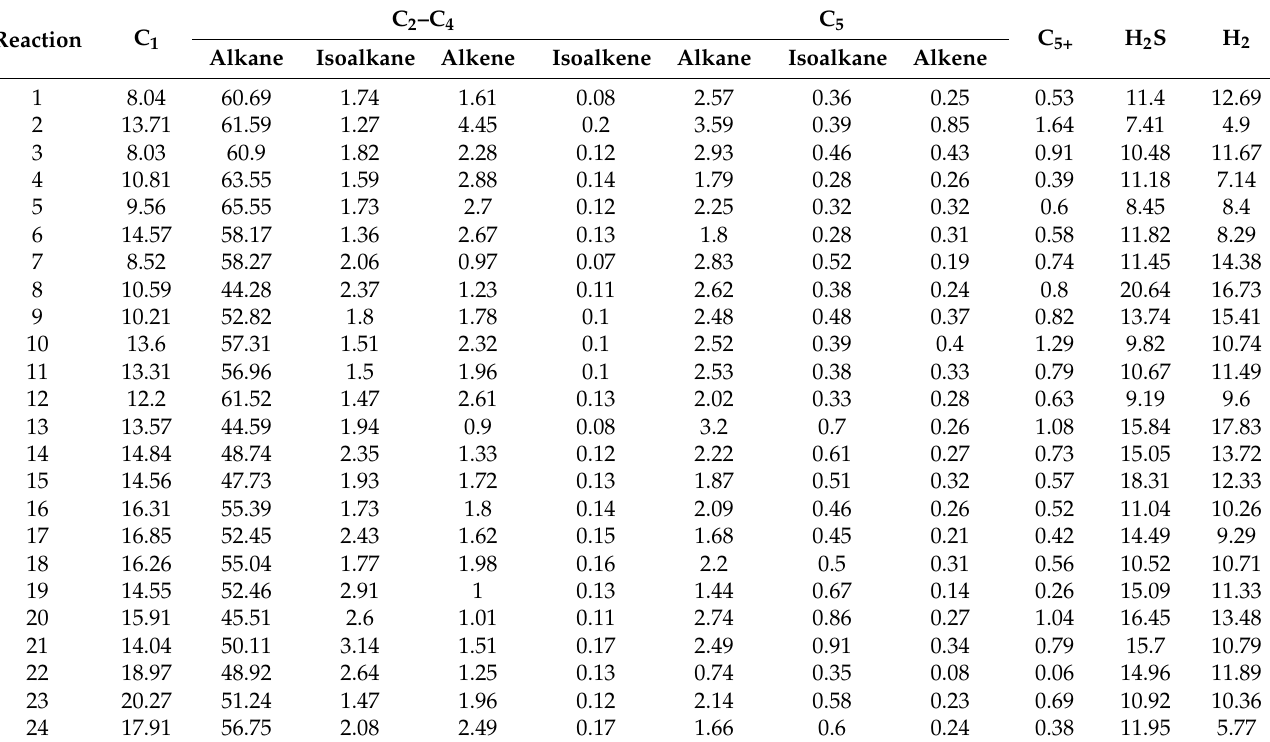
Figure 2. Composition of the gaseous products of the hydrocracking reaction. Table 3. Composition of the gaseous products of hydrocracking